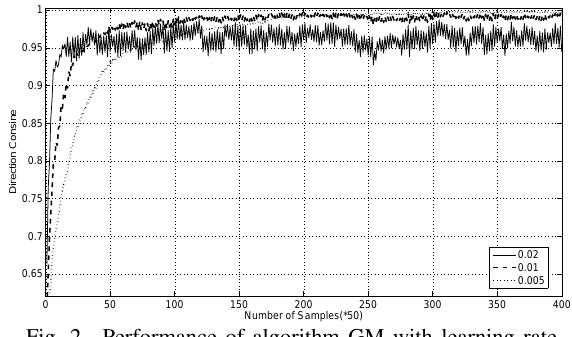
Fig. 2. Performance of algorithm GM with learning rate η = 0 . 02 , 0 . 01 , 0 . 005 respectively.